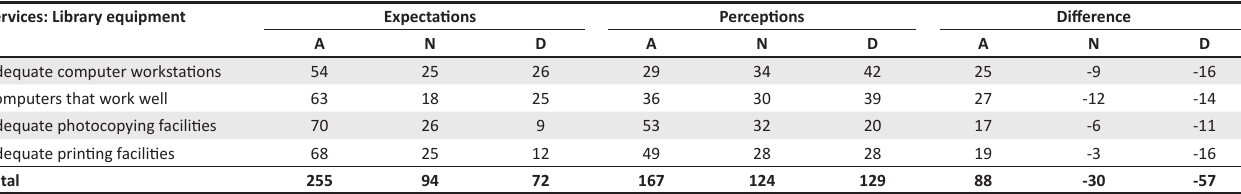
TABLE 3: Library